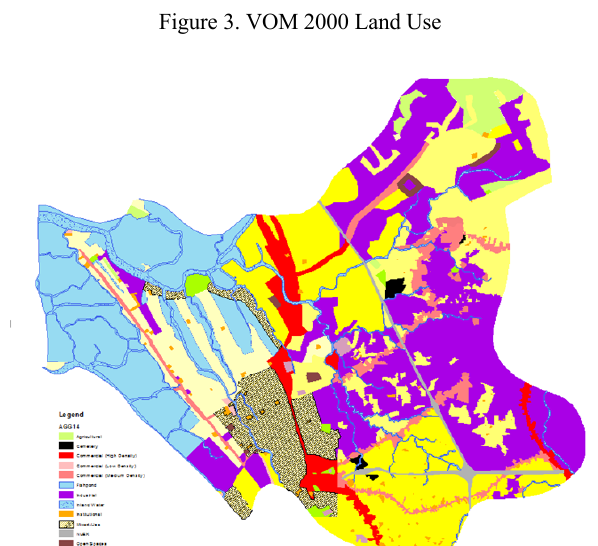
Figure 3. VOM 2000 Land Use